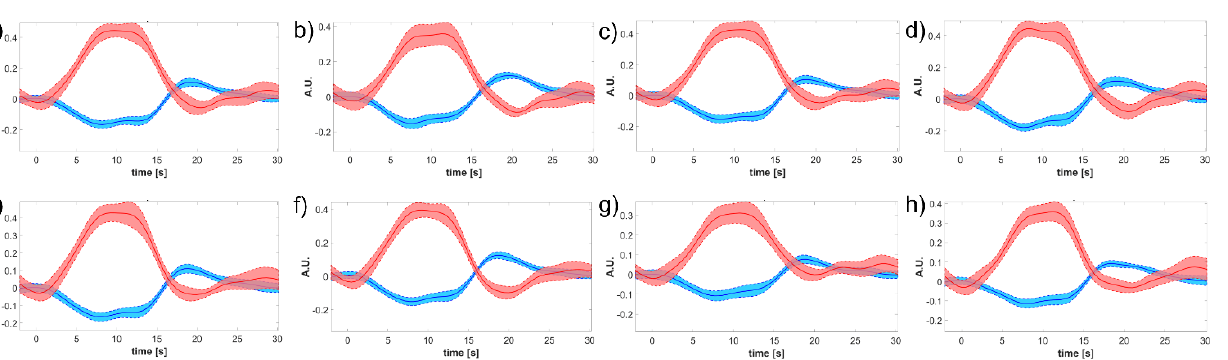
Figure 8. Subject-specific block-averaged responses across pipelines of Δ[𝐻𝑏𝑂 2 ] and Δ[𝐻𝑏𝑅] re- lated to left-hand motor grasp and a measurement channel placed over the left motor region (i.e., ipsilateral hemisphere). ( a ) SC-MARA-spline, ( b ) MC-MARA-spline, ( c ) SC-MARA-tPCA, ( d ) MC- MARA-tPCA, ( e ) HybridMARA-spline SG, ( f ) HybridMARA-tPCA SG, ( g ) TDDR, and ( h ) Wavelet method.